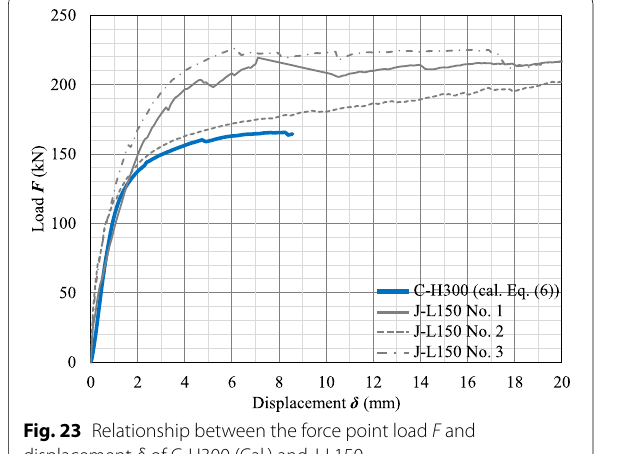
Fig. 23 Relationship between the force point load F and displacement δ of C-H300 (Cal.) and J-L150